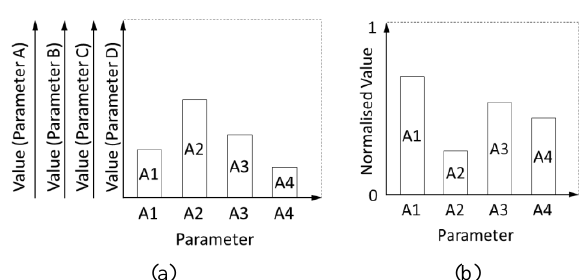
Figure 4 A segmentation done with four parameters A1 to A4 (e.g., curvature, etc). (a) The parameters have different useable ranges. (b) For visual convenience the parameters are normalised against their useable